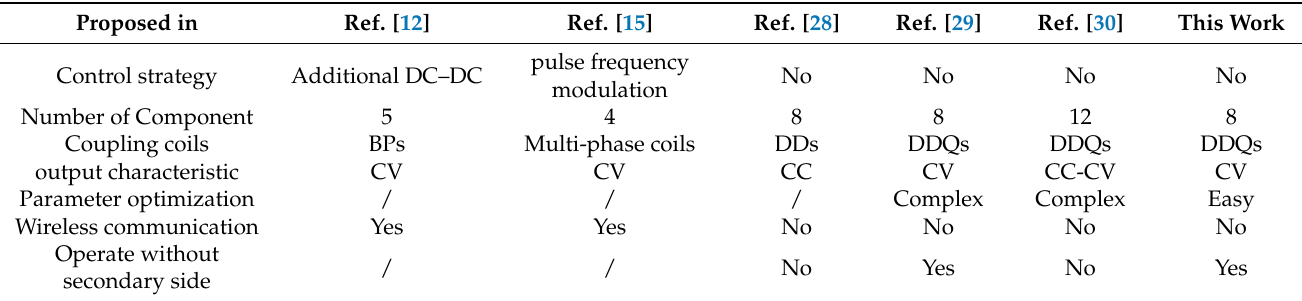
Table 2. Comparisons with existing